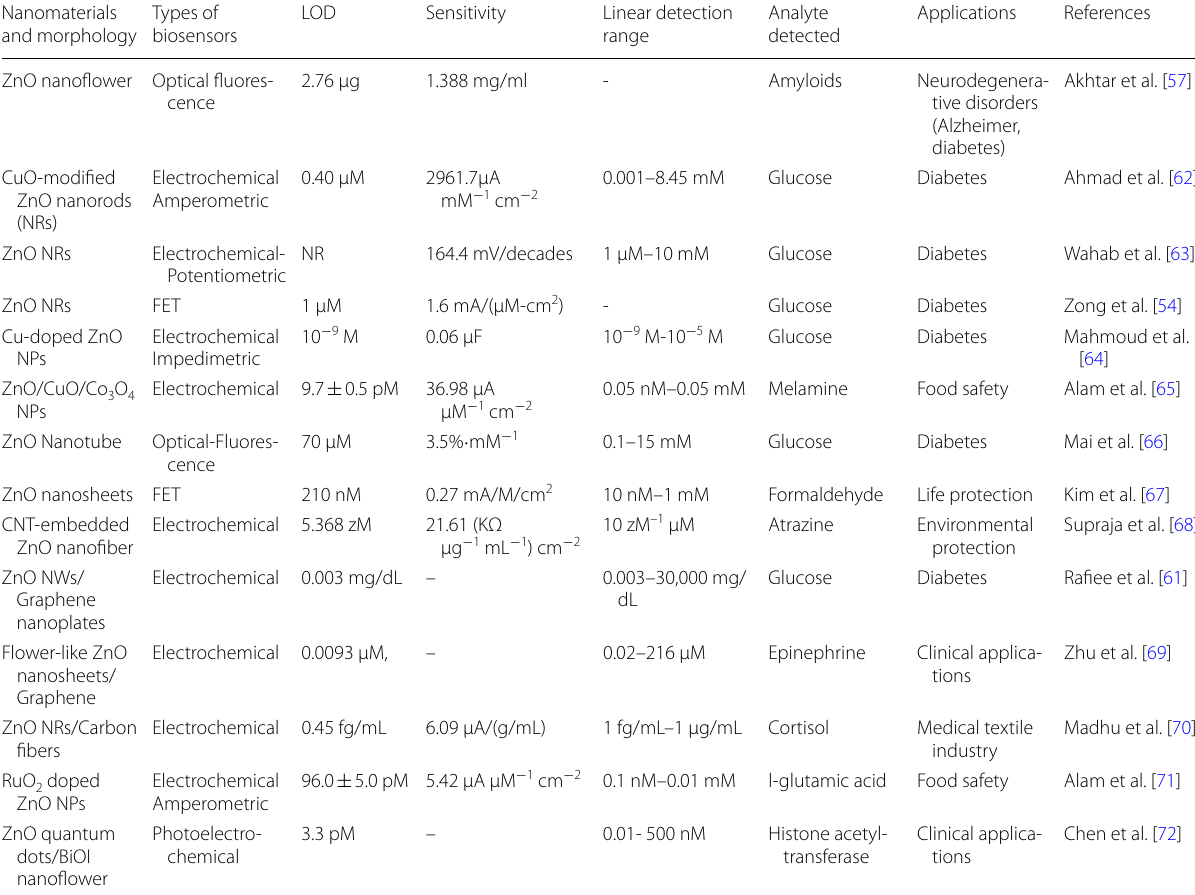
Table 1 Selected recent biosensor studies based on nanomaterials including ZnO nanostructures Nanomaterials Types of and morphology biosensors